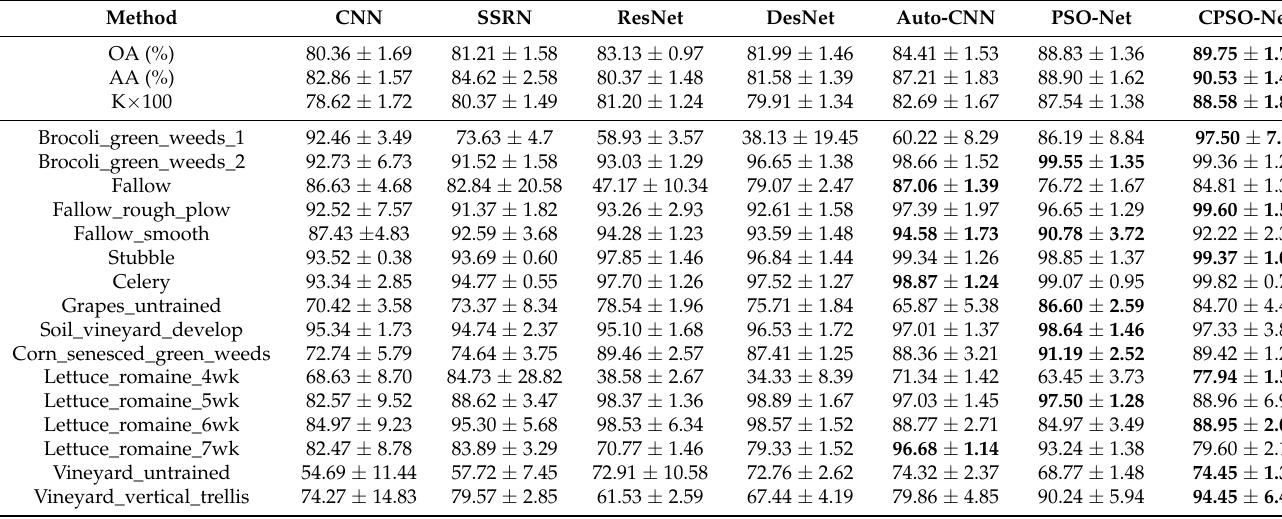
Table 9. Classification accuracy with bolding the best accuracy based on the unbiased Salinas dataset, run five times. Method